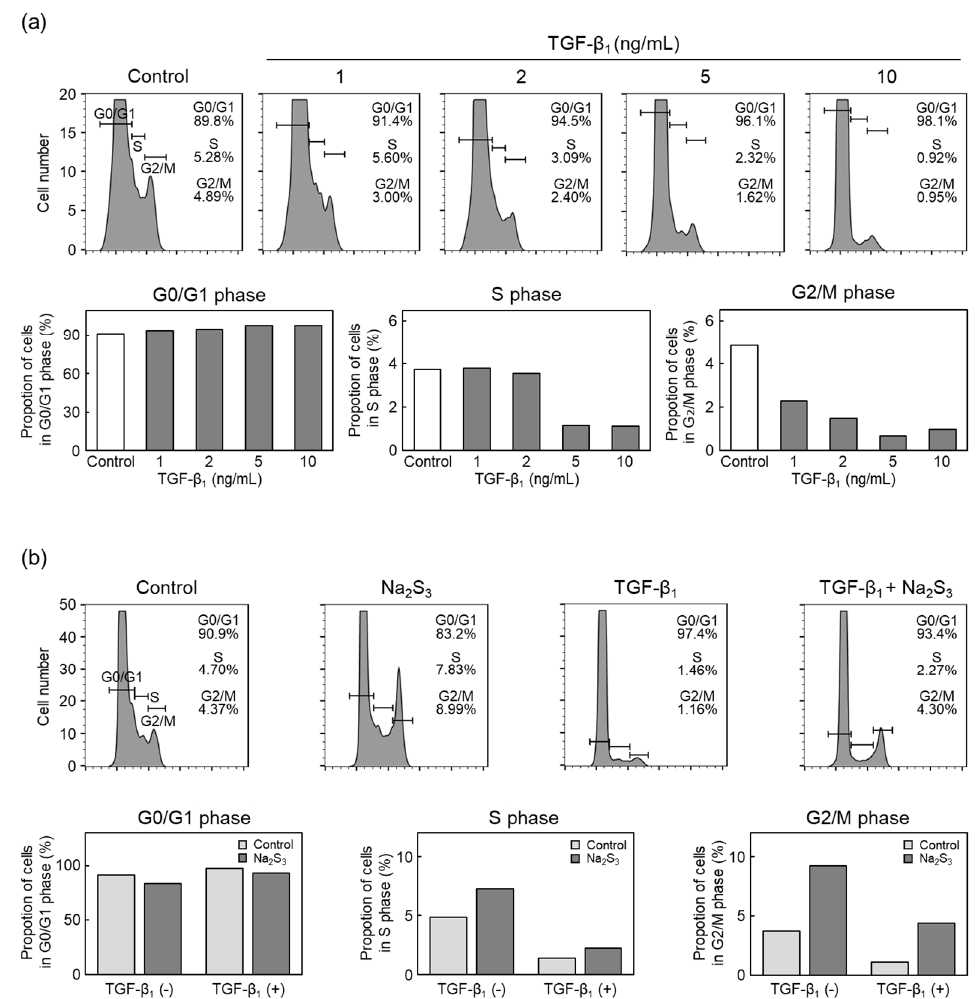
Figure 2. Effects of RSS on TGF- β 1 -induced inhibition of vascular endothelial cell proliferation. ( a ) Cell cycle distribution of vascular endothelial cells treated with TGF- β 1 . Sparse cultures of vascular endothelial cells were treated with TGF- β 1 (1, 2, 5, or 10 ng/mL) for 24 h and were stained with propidium iodide. DNA histograms of the cell cycle were analyzed (upper panels), and the proportions of cells in G0/G1, S, and G2/M phases were quantified from the histograms (lower panels). The data are representative of two independent experiments. ( b ) Cell cycle distribution of vascular endothelial cells treated with Na 2 S 3 and TGF- β 1 . Sparse cultures of vascular endothelial cells were pretreated with Na 2 S 3 (100 µM) for 3 h and then treated with TGF- β 1 (10 ng/mL) for 24 h. The DNA histograms of the proportions of cells in G0/G1, S, and G2/M phases were quantified (lower panels). The data are representative of three independent experiments.